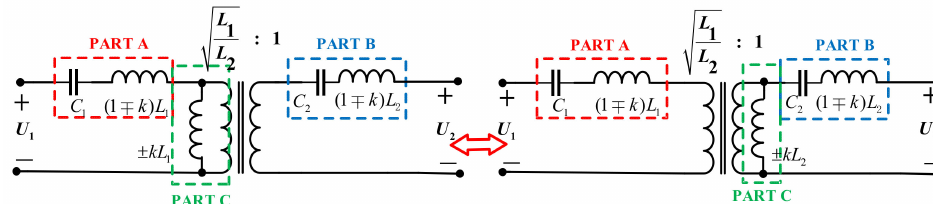
Figure 8. The equivalent model of the III_CV_CV circuit. Table 1. Modeling of constant voltage to constant voltage for loosely coupled transformers.